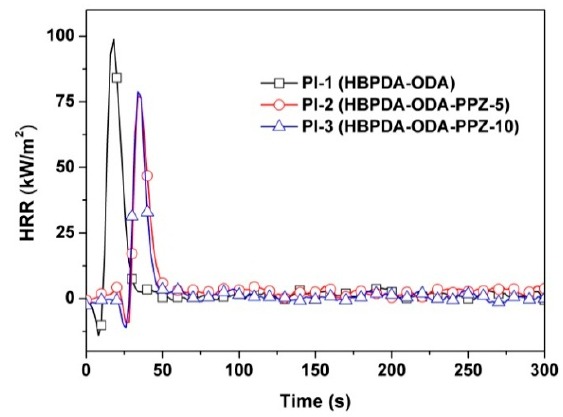
Figure 12. HRR plots of PI films.